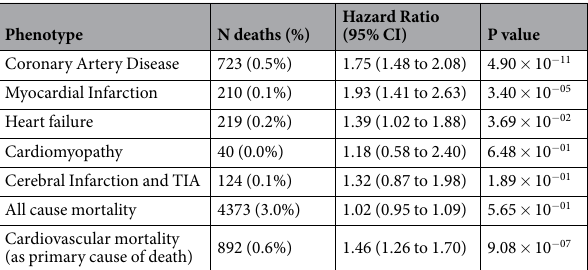
Table 3. Cox survival model predicting hazard of death using the genetic risk score based on the 71 genome wide significant CAD variants. Abbreviations: N = Number, CI = Confidence Interval, TIA = Transient Ischemic